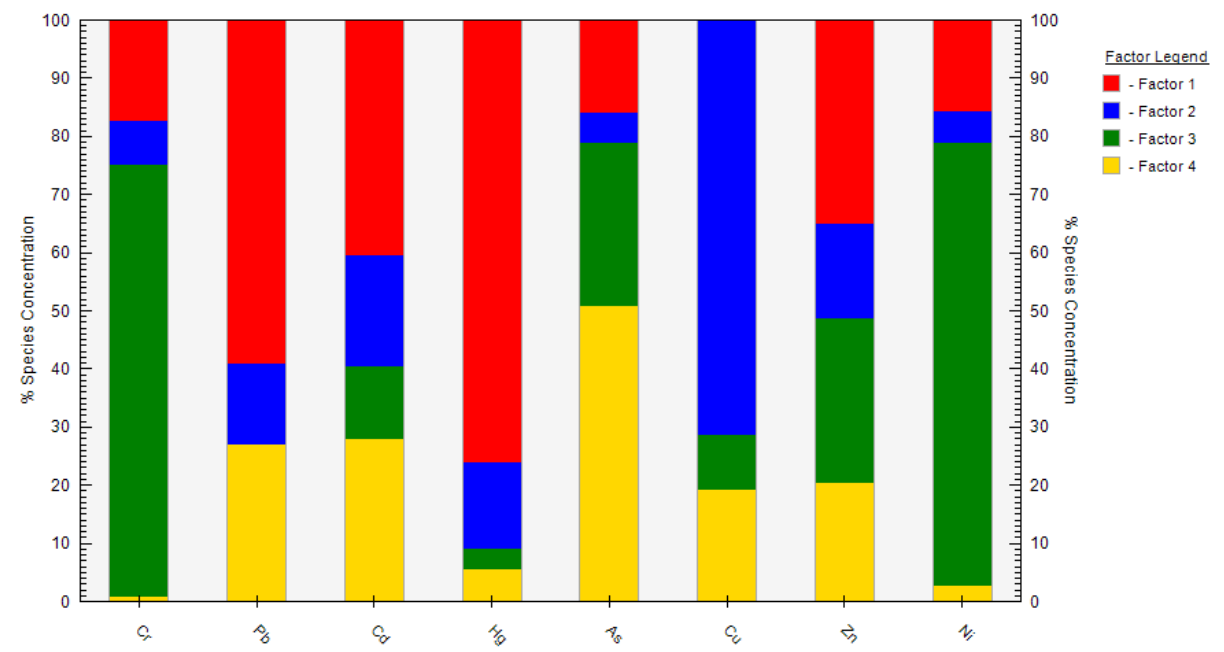
Figure 9. Factor fingerprints of sources of soil TEs in Yuyao City produced by PMF.